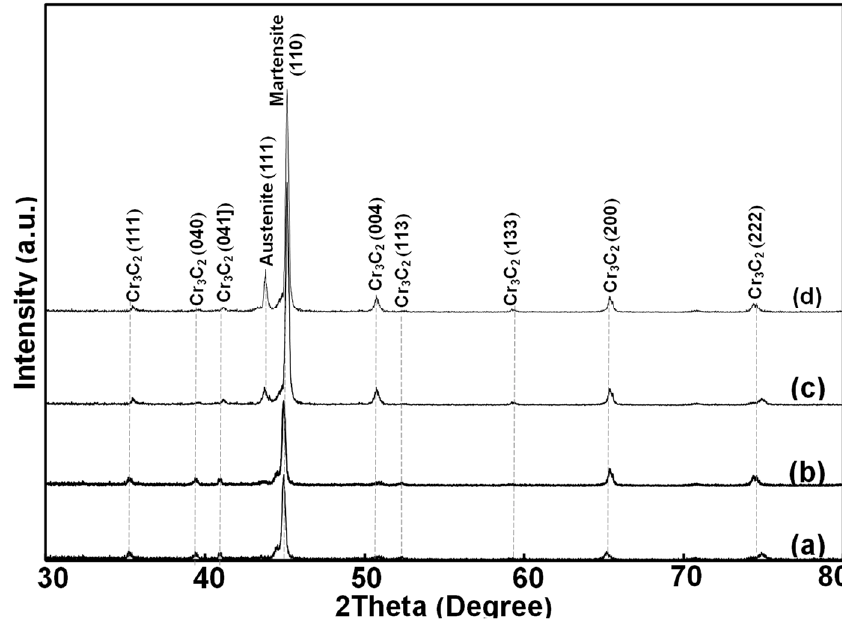
Figure 6. XRD Pattern of welded specimens: ( a ) S1, ( b ) S2, ( c ) H1, and ( d ) H2.